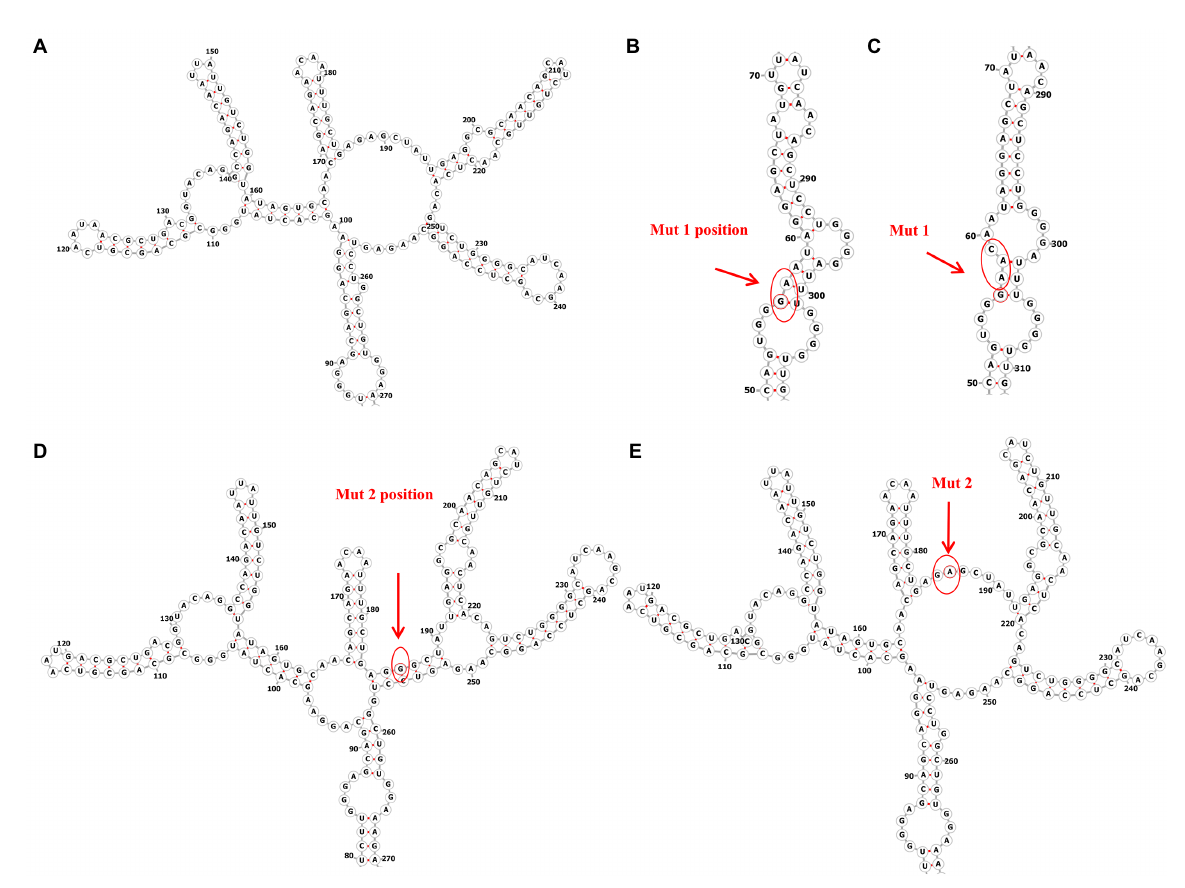
FIGURE 3 Predicted RNA secondary structure of subtype B RRE and each mutation site. (A) The RNA secondary structure of subtype B RRE circulating in China. (B,D) The RNA secondary structure of subtype B RRE in the United States. (C,E) Mutation at site RRE56-57ins AAC and site RRE-G186A